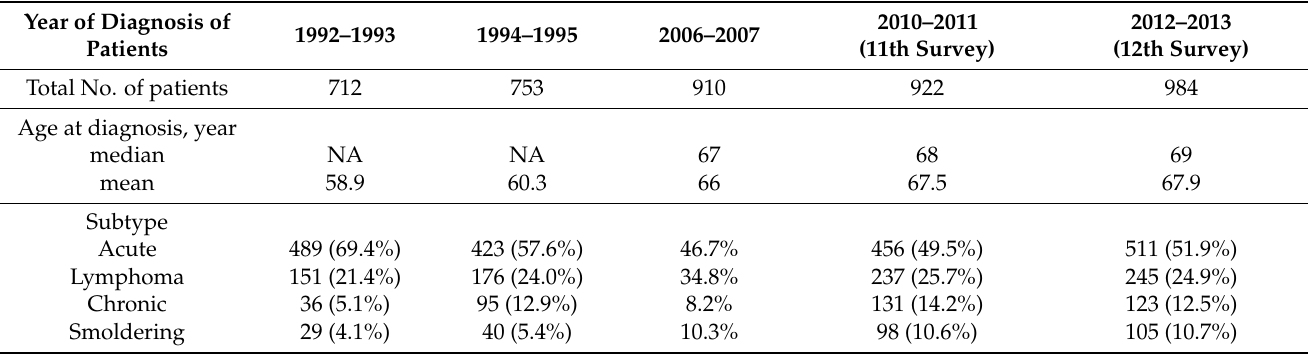
Table 4. Comparison of the results of nationwide